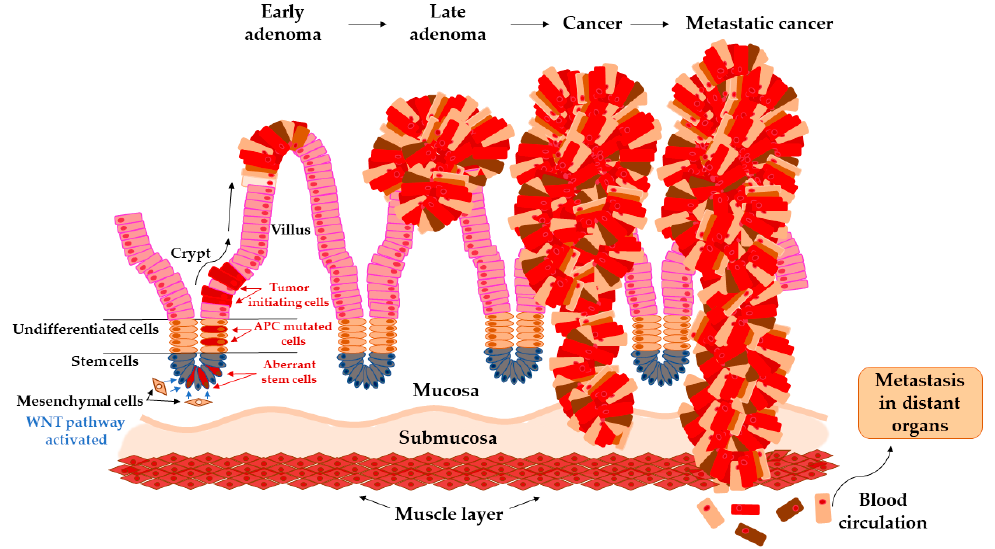
Figure 1. Arise of tumor-initiating cells from aberrant colon crypt and subsequent transition of early adenoma to metastatic cancer.